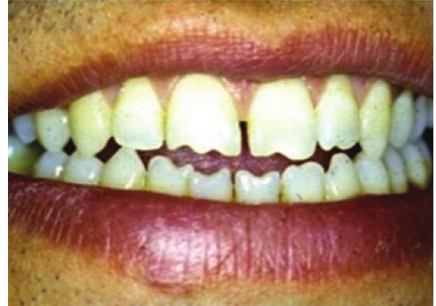
Figure 5: The “vertical” positioning and crushing of pumpkin and watermelon seeds using the anterior teeth has resulted in the abrasion “notches” in those teeth.